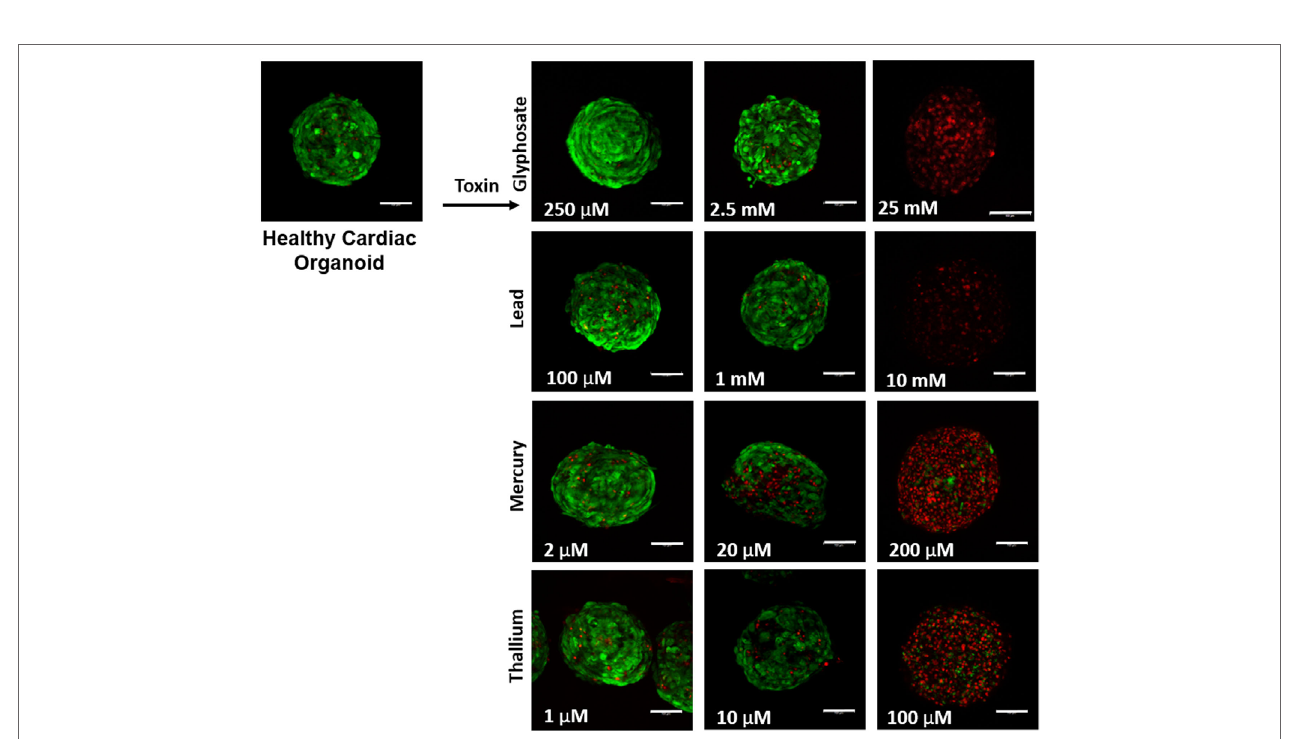
FigUre 2 | Visual assessment of environmental toxin effects on cardiac organoids by live/dead assay. The effects of glyphosate, lead, mercury, and thallium on cardiac organoids using ethidium homodimer dead (red) and calcein AM live (green) staining. Scale bars are equal to 100